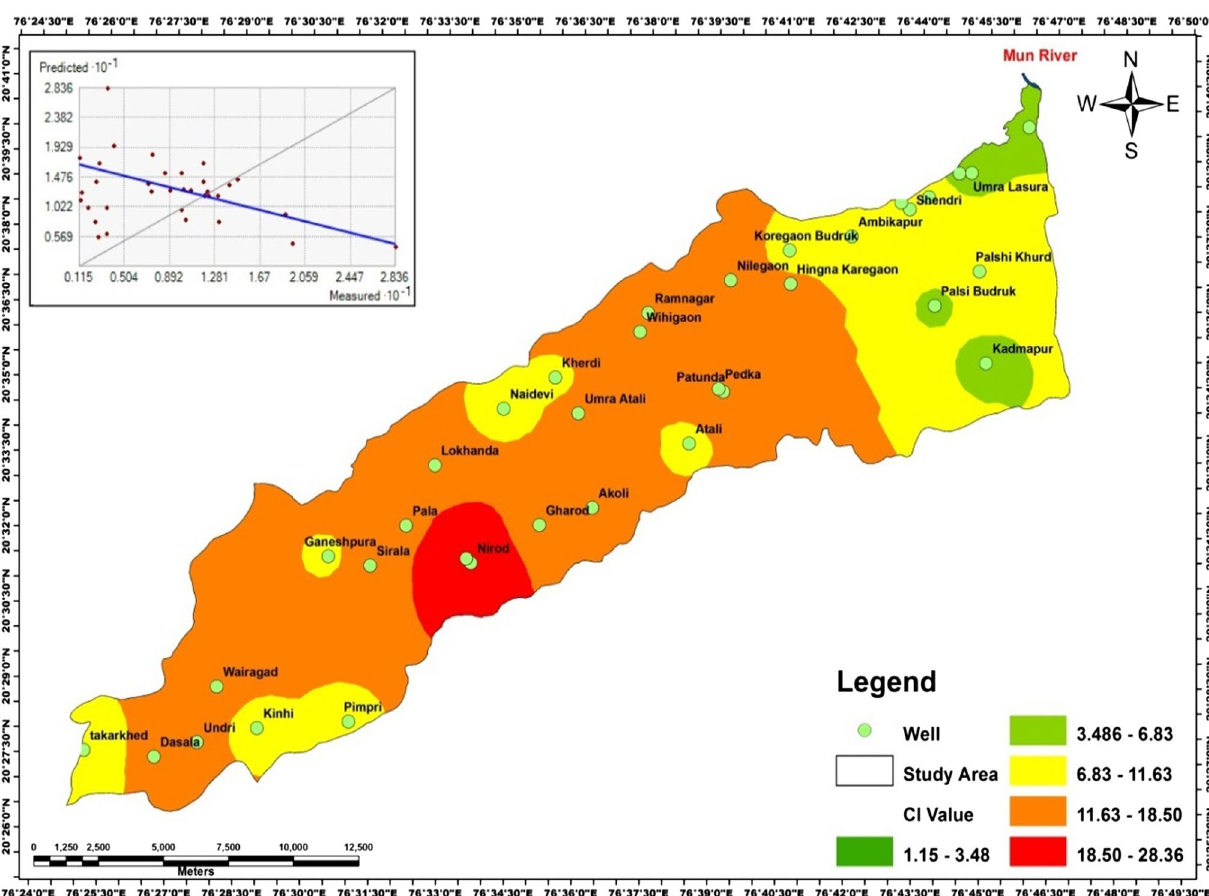
Fig. 8 Spatial distribution map of Cl of 2013